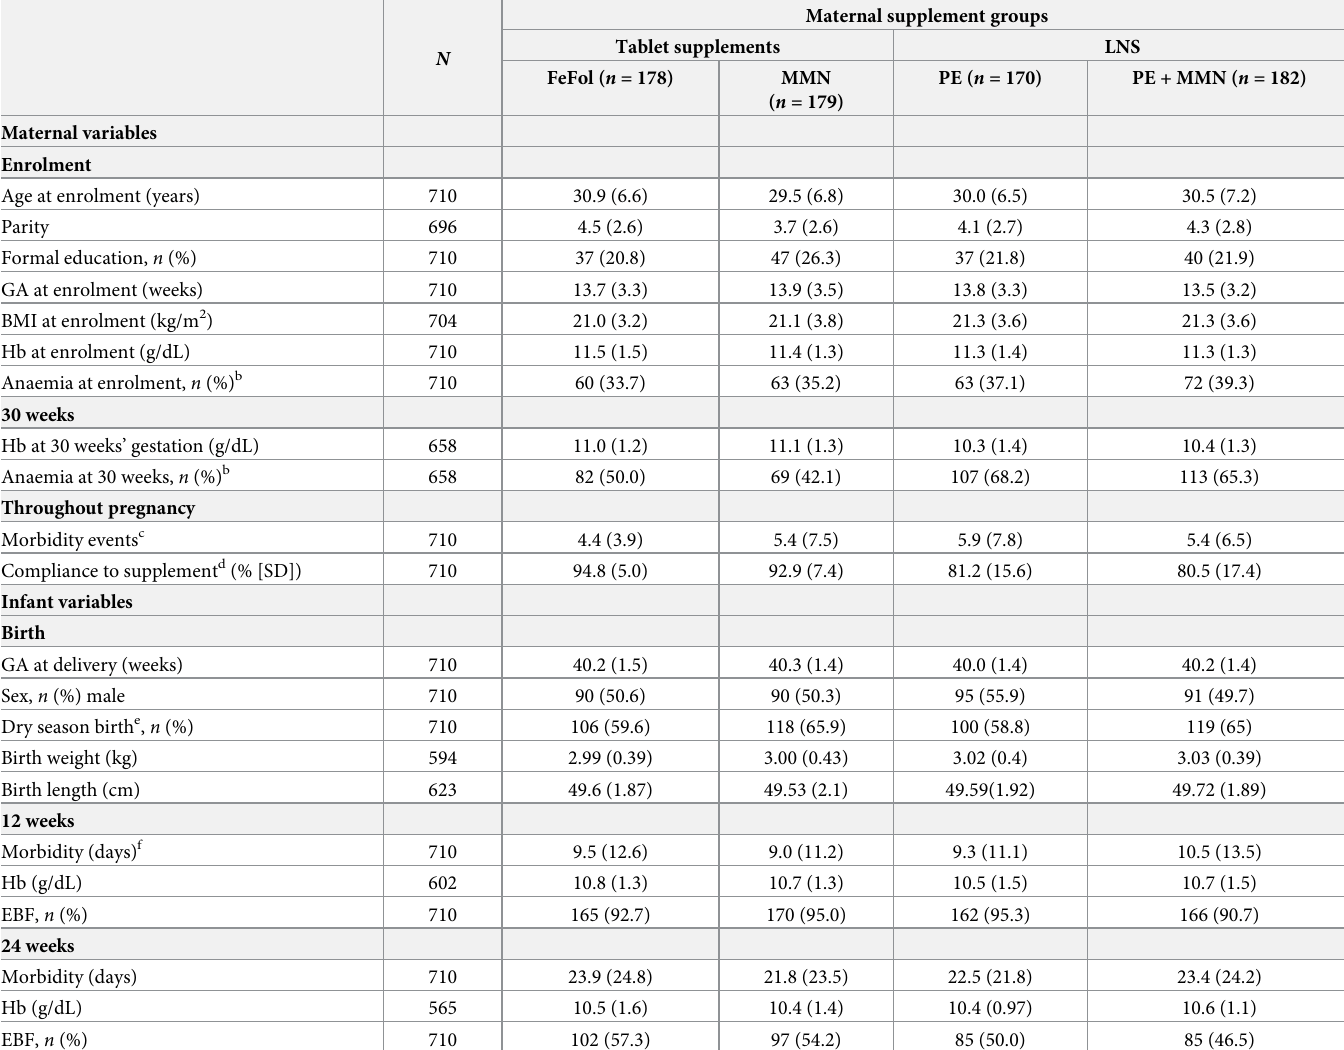
Table 2. Participant characteristics by maternal supplement group a